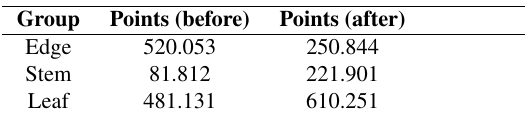
Table 2: Number of points in each group before and after the edge effect correction Group Points (before) Points (after) Edge 520.053 250.844 Stem 81.812 221.901 Leaf 481.131